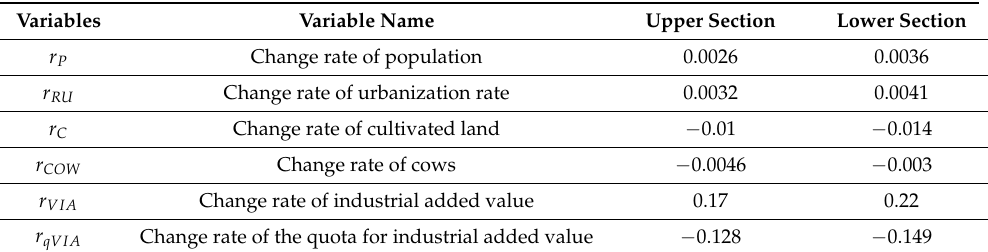
Table 3. The parameter settings of the evolution model.